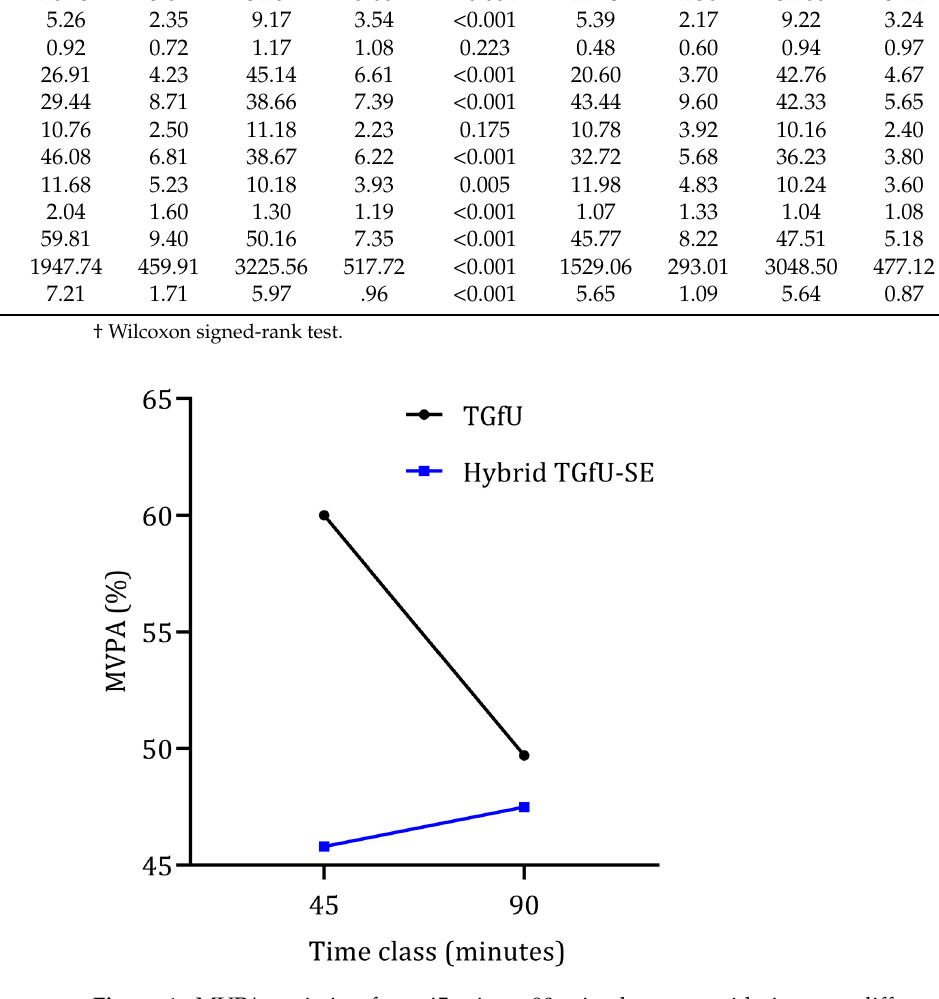
Figure 1. MVPA variation from 45 min to 90 min classes considering two different pedagogical models (TGfU and hybrid TGfU-SE).